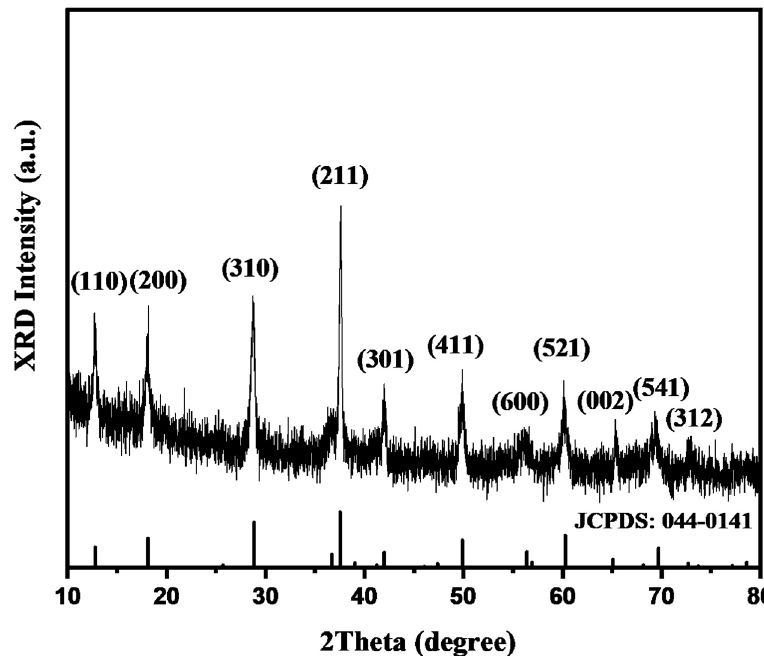
Figure 1. PXRD pattern of the hydrothermally prepared α -MnO 2 .